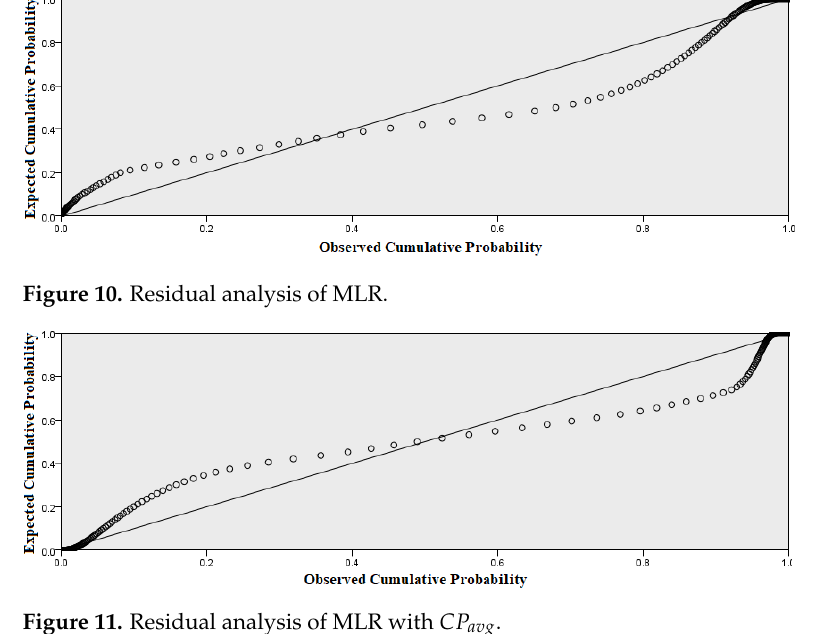
Figure 11. Residual analysis of MLR with CP avg .